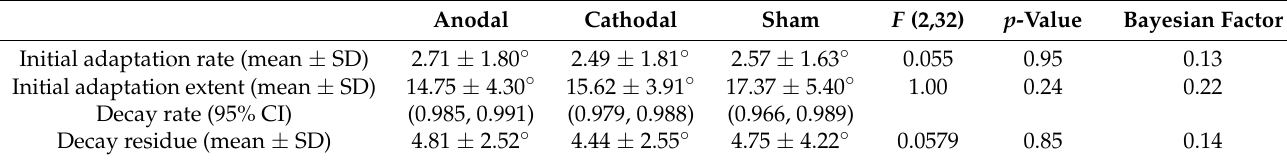
Table 2. Group comparisons of performance measures in Experiment 2.